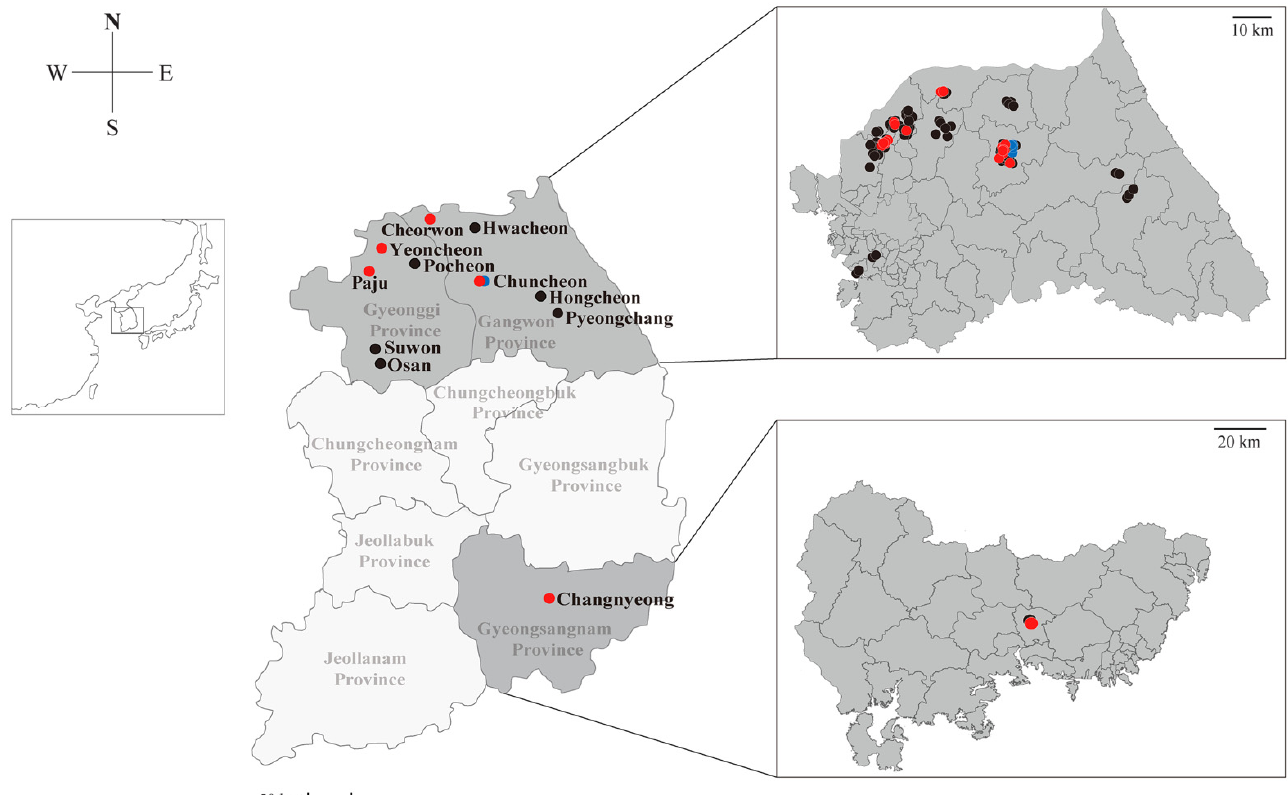
Figure 1. Geographic locations of the Republic of Korea, showing the shrew trapping sites described in this study. The trapping sites include Cheorwon, Chuncheon, Hwacheon, Hongcheon, and Pyeongchang in Gangwon Province; Osan, Paju, Pocheon, Suwon, and Yeoncheon in Gyeonggi Province; and Changnyeong in Gyeongsangnam Province. Red and blue dots represent trapping sites for shrews positive for the presence of Gamak virus (GAKV) and Daeryong virus (DARV), respectively. Black dots indicate that trapping sites where paramyxoviral RNA was not detected in the shrews. This figure was constructed by using Adobe Illustrator CS6 (http://www.adobe.com/products/illustrator.html, 3rd March 2021).